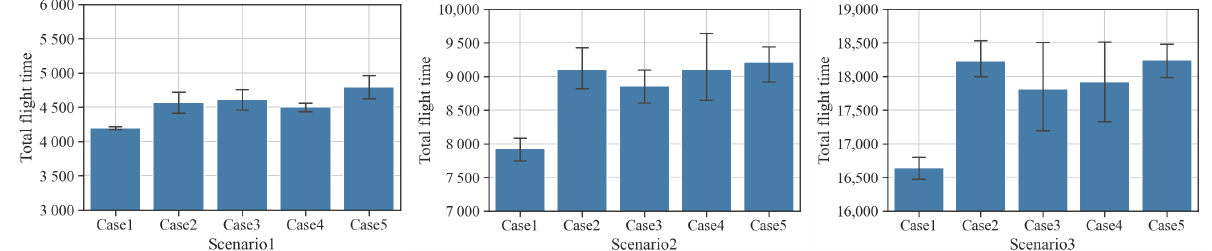
Figure 10. Total flight time of the UAV in each scenario. The values are averages of 10 training trials, and the error bars represent 95% confidence